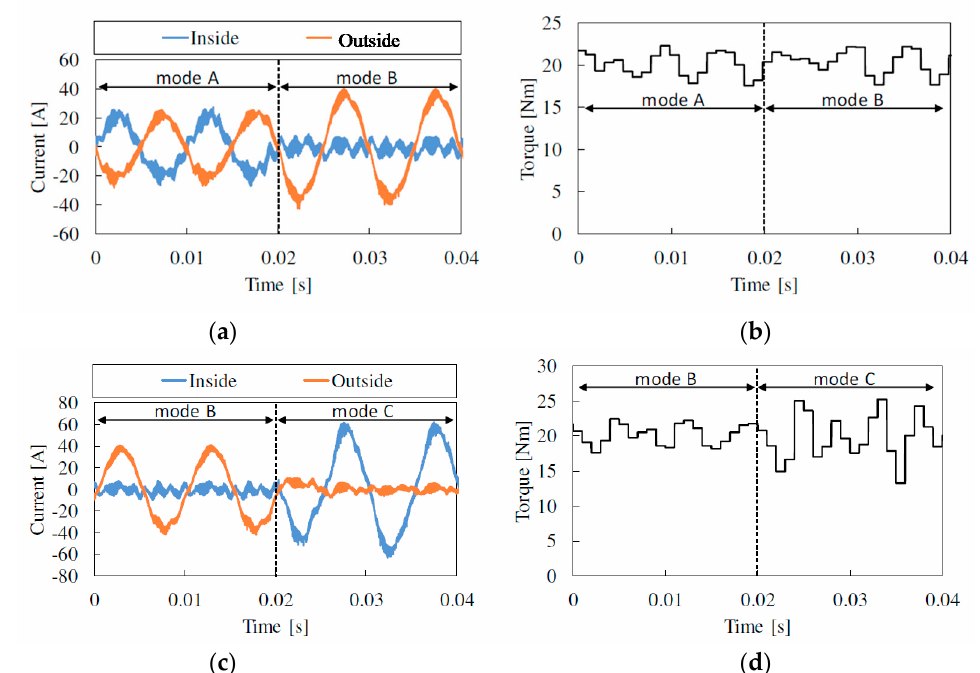
Figure 19. Experimental results of winding changing. Current waveform in each winding and torque waveform are shown. The current amplitude of each winding is calculated, the output torque is not to be changed. ( a ) Current waveform of each winding. The mode is changed from mode A to mode B. ( b ) Output torque waveform of each mode. The mode is changed from mode A to mode B. ( c ) Current waveform of each winding. The mode is changed from mode B to mode C. ( d ) Output torque waveform of each mode. The mode is changed from mode B to mode C.